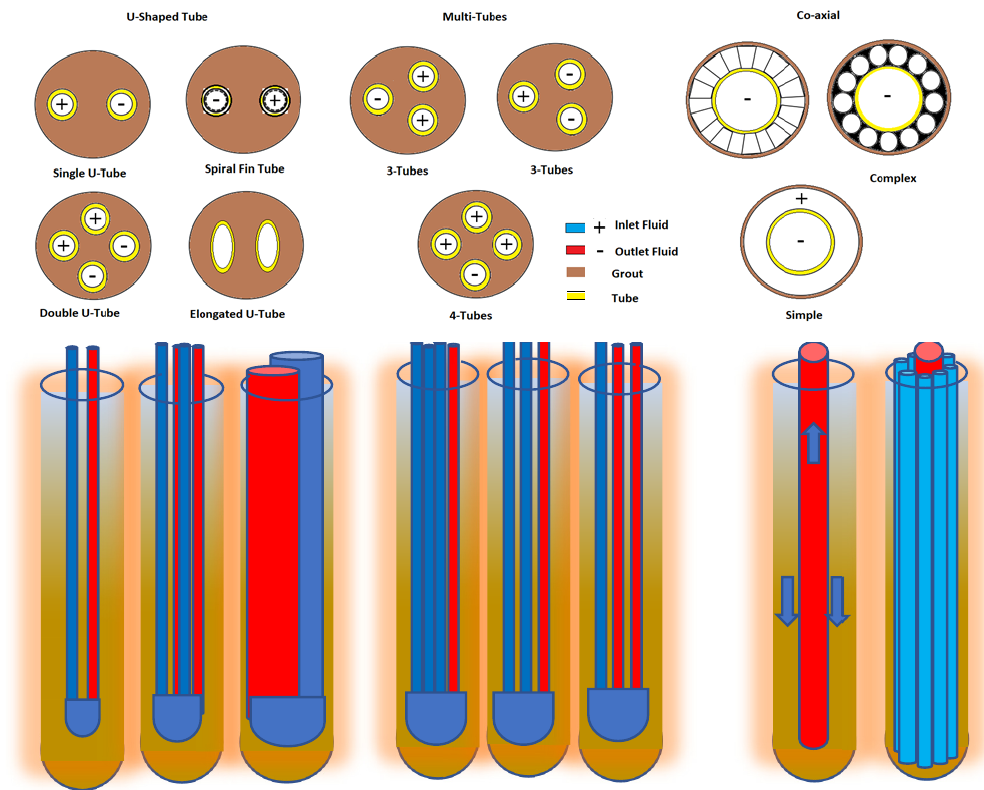
Figure 3. The cross-sections of various configurations of BHE.